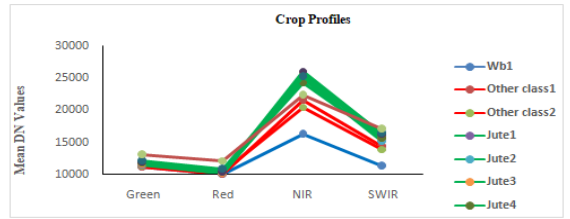
Figure 5: False colour composite image (left) and Classified image (right) of Murshidabad, West Bengal